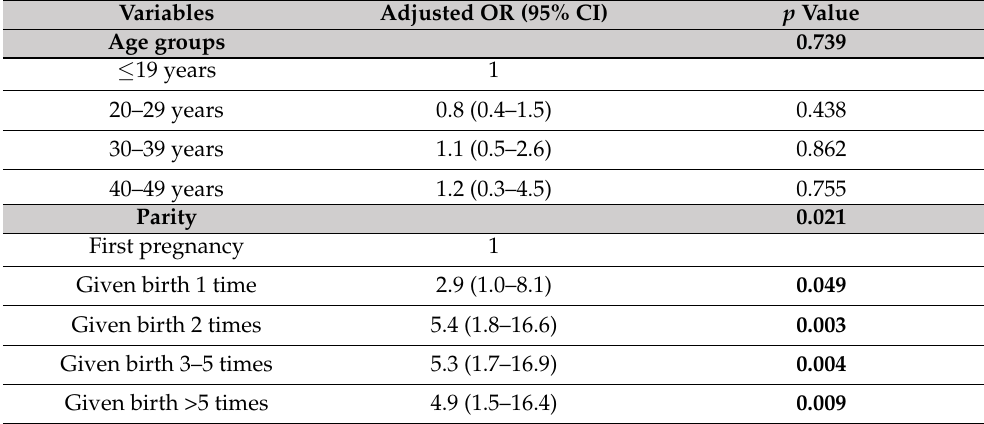
Table 6. Final logistic regression model of knowledge of ODS as a function of independent